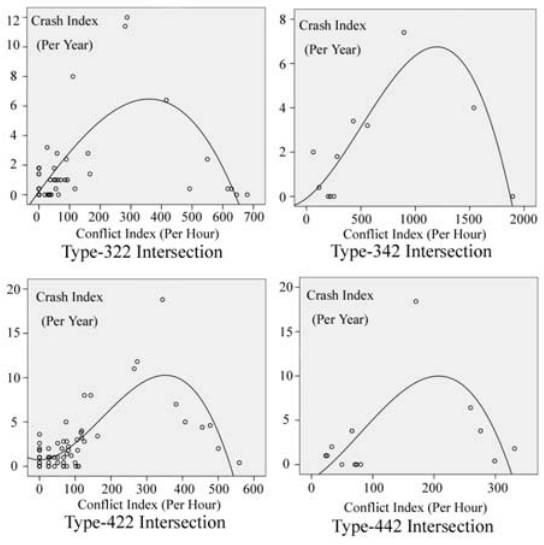
Fig.3. Crash and Conflict Severity Model Matching Table 4. Five Kinds of Regression Models for Four